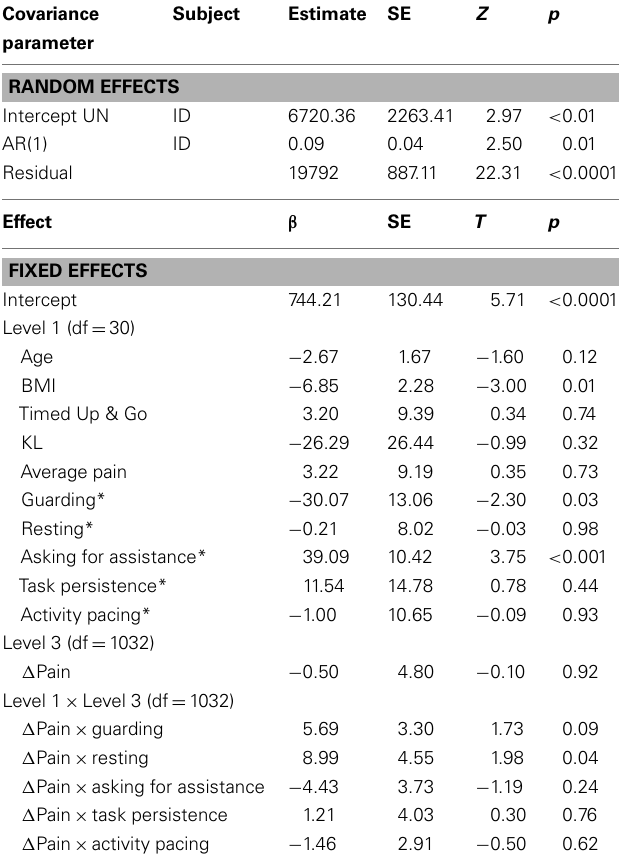
Table 4 | Multilevel model results predicting momentary activity from interaction terms including coping subscales and pain.